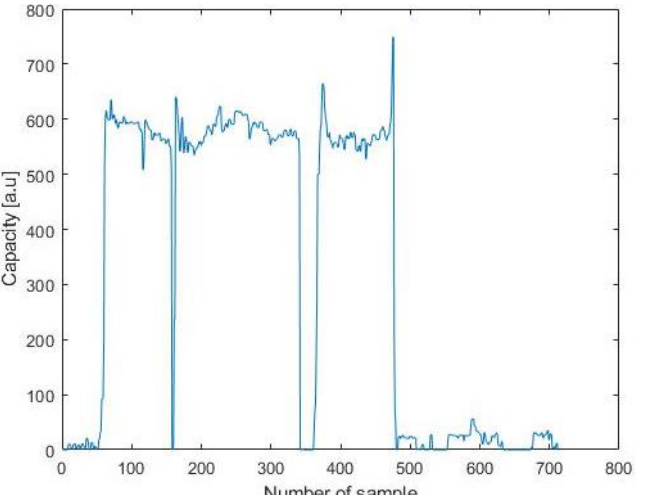
Figure 7. Structure of the system during the experiments.